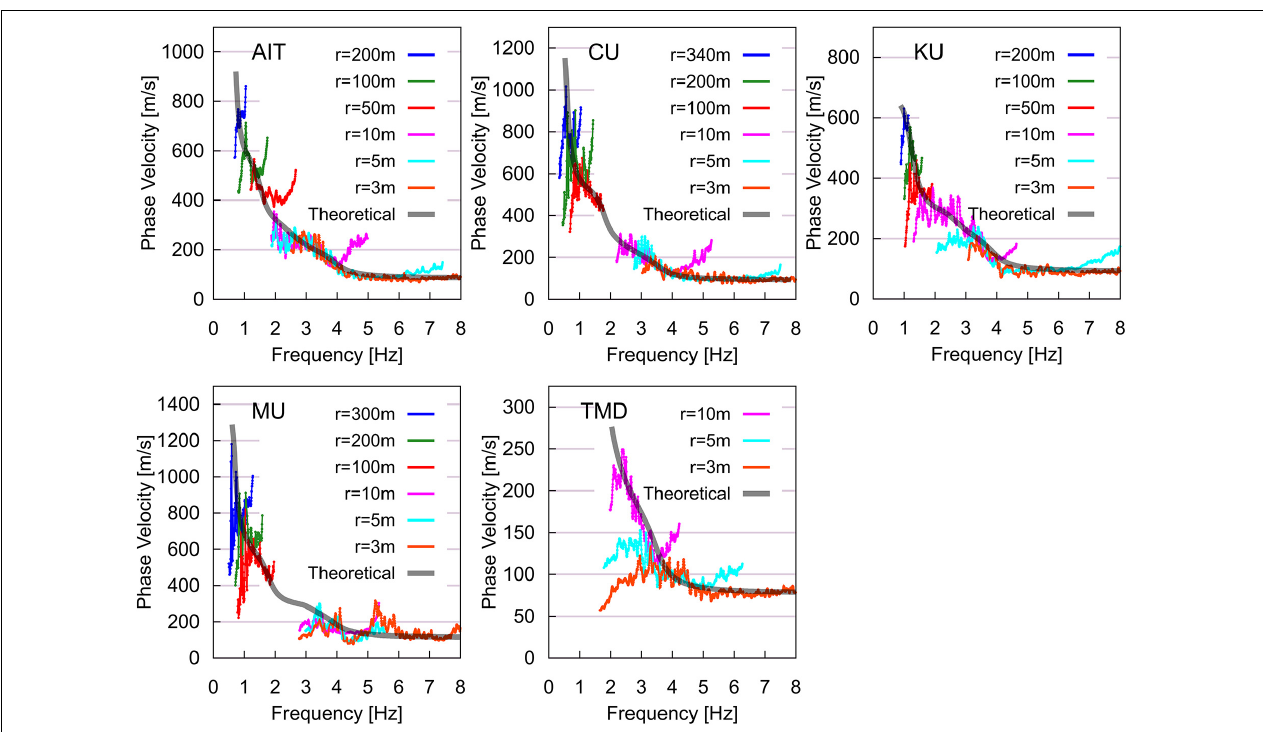
FIGURE 8 | Phase-velocity dispersion curves of the Rayleigh waves at five sites. The gray lines were derived from the final inversion profile; the colored lines represent the various array sizes.